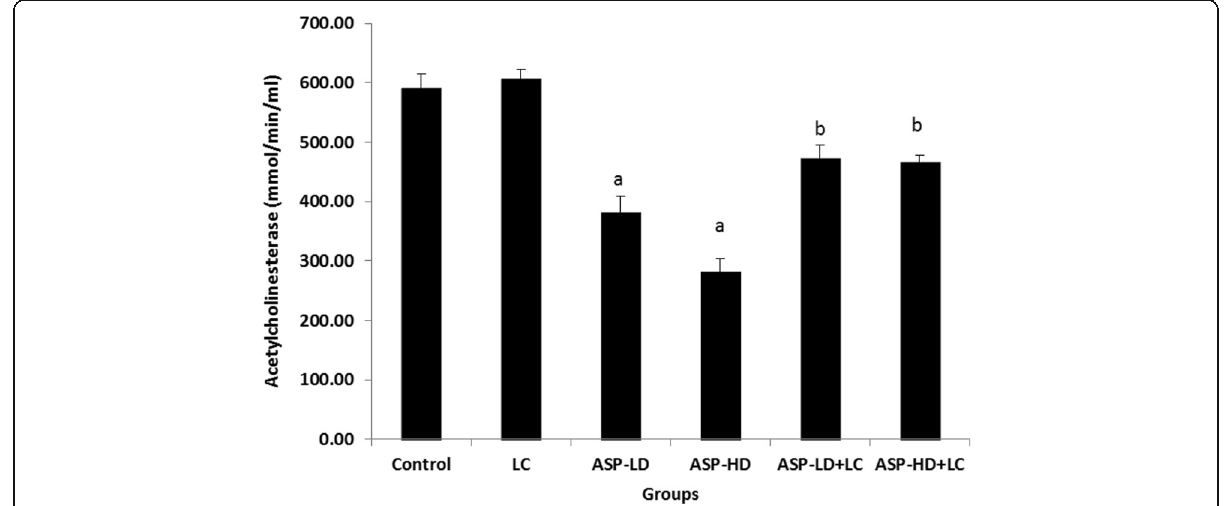
Fig. 3 Effect of L -carnitine on acetylcholinesterase in the serum of male rats treated with aspartame. Values are expressed as mean ± SE, n = 8. The value of the significant was represented at the top of the column. a Significant difference as compared to control, and b Significant difference as compared to its relative group of ASP ( P ≤